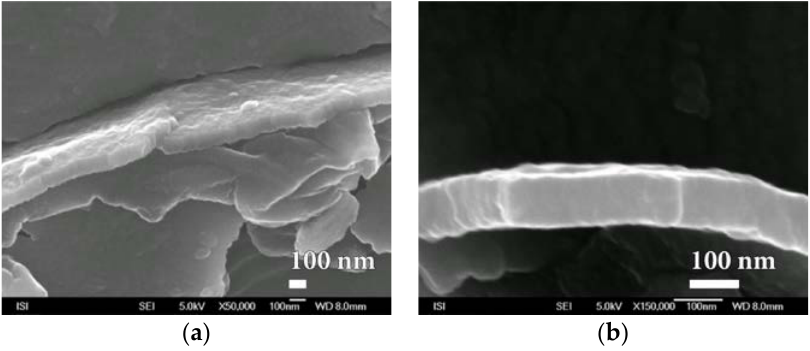
Figure 17. SEM photographs of SiO x barrier nanocoating fracture prepared by plasma deposition by HMDSO method on PEVA foil at magnification of ( a ) 50,000× and ( b ) 150,000×.